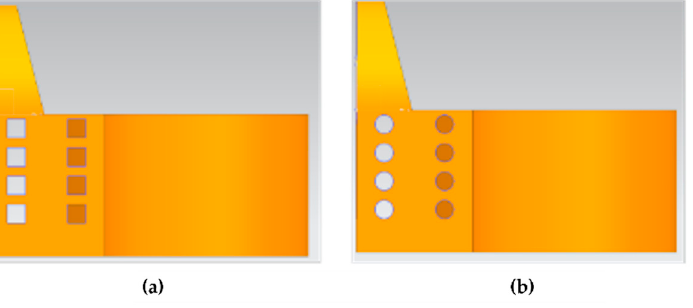
Figure 21. Topological structure of swing frame: ( a ) opening square hole; ( b ) opening round hole.